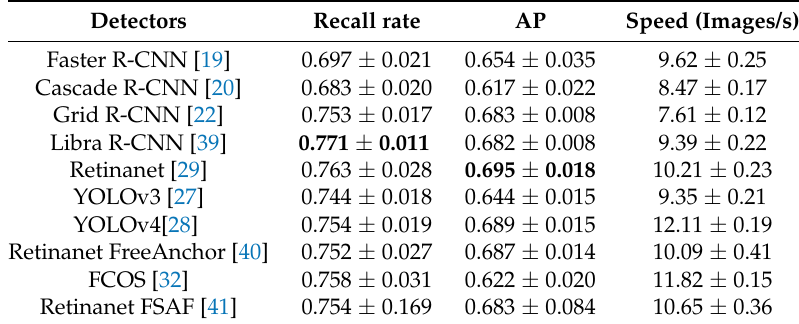
Table 5. Results on the EPD-C subset. Train resolution, 1 m/pixel; test resolution, 1 m/pixel. AP refers to average precision. Recall, AP, and speed are expressed in the format of mean ± standard deviation on the basis of 10 rounds of test